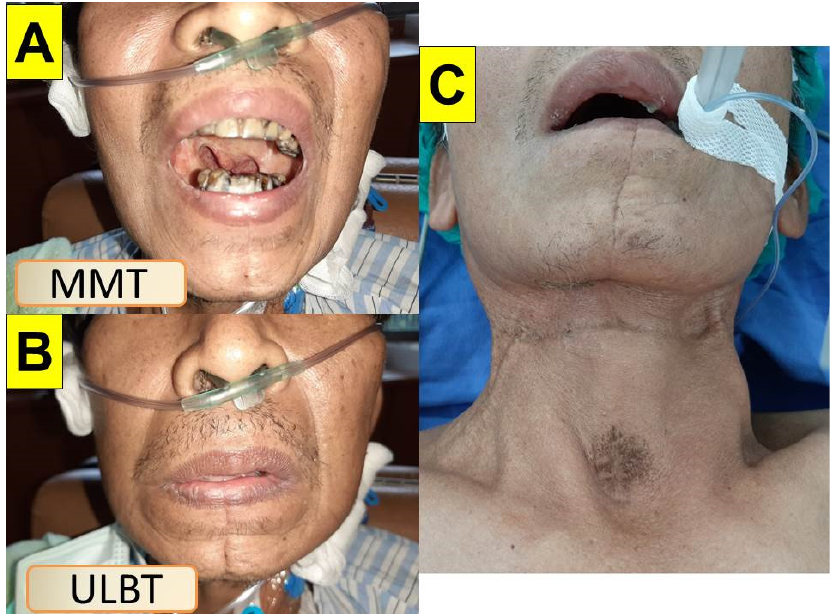
Figure 6. A patient was scheduled to receive video-assisted thoracic surgery (VATS) due to pulmonary empyema. He had prior history of tongue cancer and had received surgical resection, radiation therapy and chemotherapy. ( A ) Mouth-opening was about 3 cm with a grade 3 modified Mallampati test; ( B ) upper lip bite test, grade 3; ( C ) the head and neck displayed surgical scars, radiation fibrosis, and tracheostomy scar. MMT: Modified Mallampati Test. ULBT: Upper lip bite test.